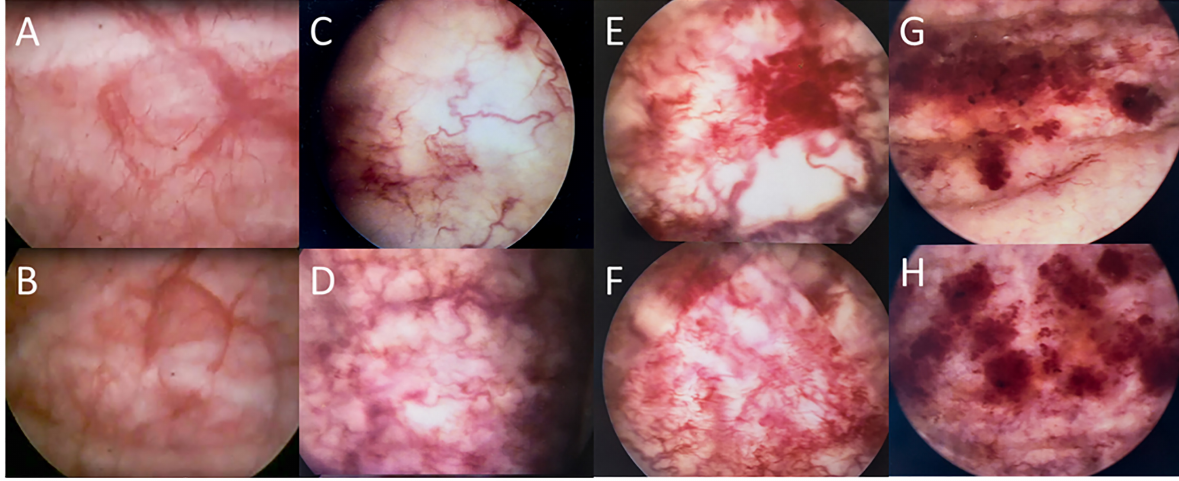
Figure 1 - Aspect of the bladder mucosa of irradiated patients with varying degrees of neovascularization comparing with normal bladder mucosa. Images were obtained during cystoscopy examinations of patients included in the study and correspond to the endoscopic findings of RTOG/EORTC late morbidity scale: A and B - normal bladder mucosa, C and D - Grade 1: slight epithelial atrophy, minor telangiectasia, E and F - Grade 2: generalized telangiectasia, G and H – Grade 3: severe generalized telangiectasia (often with